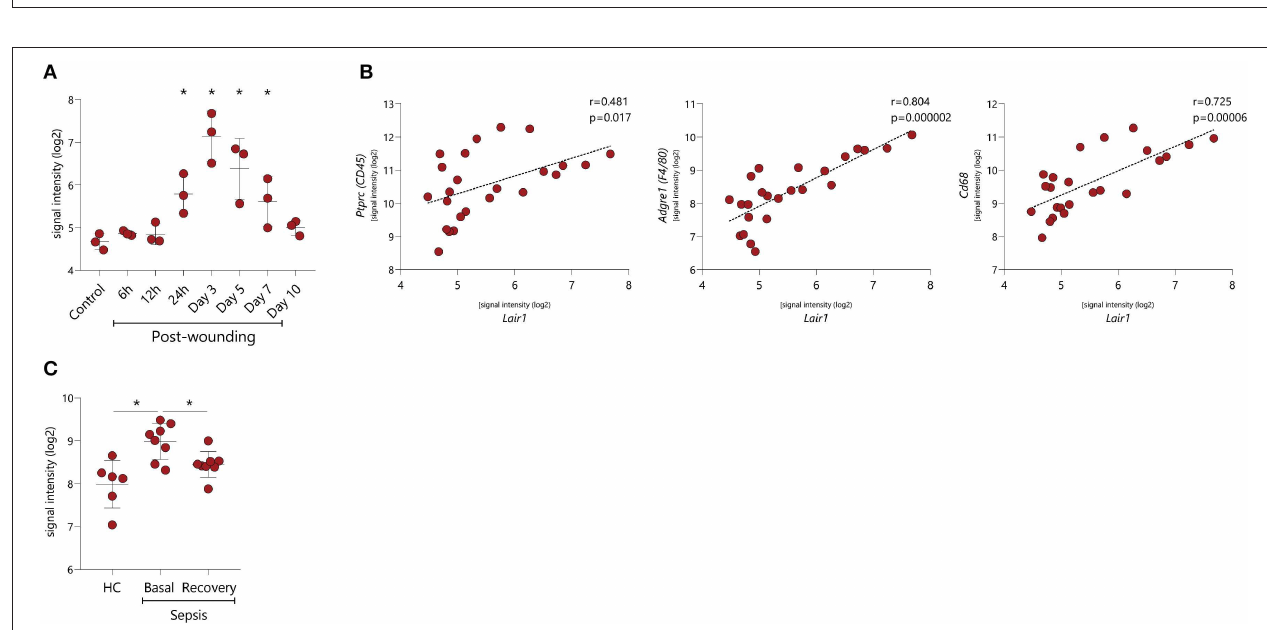
FIGURE 5 | expression of CD1a, CD1c, CD11c, CD14, CD141, CD86, CD80, HLA-ABC, and HLA-DR was assessed by flow cytometry. Quantification is shown as percentage (%) of positive cells or median fluorescence intensity (MFI). (B) Representative plots or histograms are shown. (C) Monocyte derived dendritic cells differentiated in the presence of anti-LAIR-1 agonist (Dx26) or isotype control were stimulated during 4h with TLR4 agonist- LPS or IFN- α and the IL12A, IL23A, IL27A, IL1B, IL10, TNF, IL6, IL8 gene expression was evaluated by qRT-PCR. Results are represented as paired samples. Statistically significant differences were